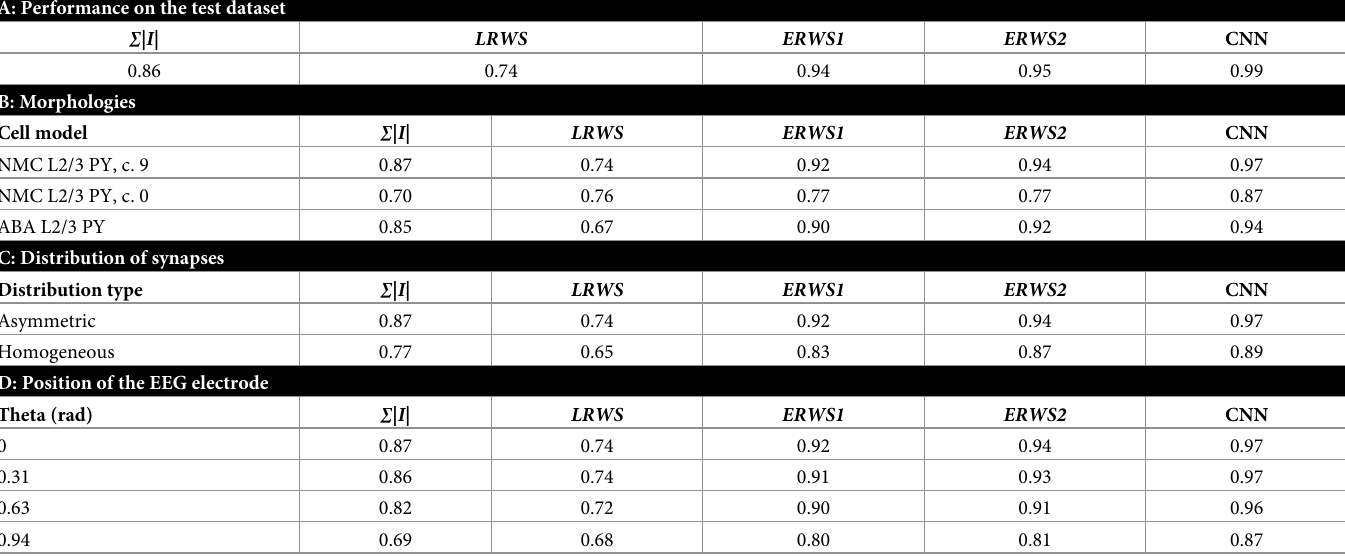
Table 2. Performance (computed as R 2 ) of the CNN in comparison with ∑ | I |, LRWS , ERWS1 and ERWS2 proxies. The performance values shown for the test dataset (A) are averaged over all samples of the test dataset, while performance values in panels B, C and D are averaged over the samples of the different network states, i.e., AI, SI and